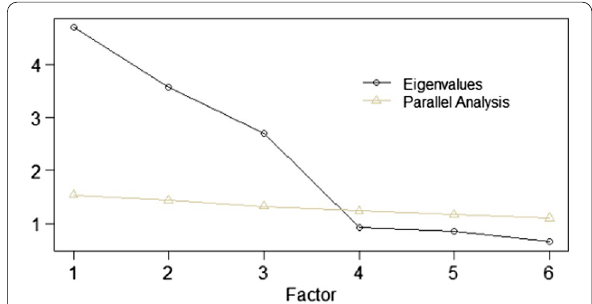
Fig. 2 Scree plot and parallel analysis from EFA